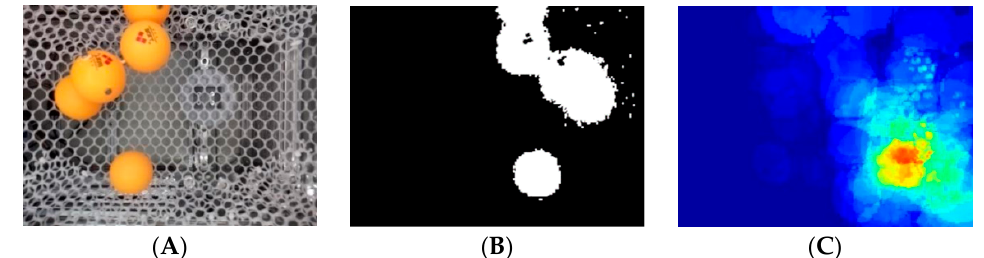
Figure 7. ( A ) The original image. ( B ) The color extracted image. ( C ) The color density thermodynamic map.